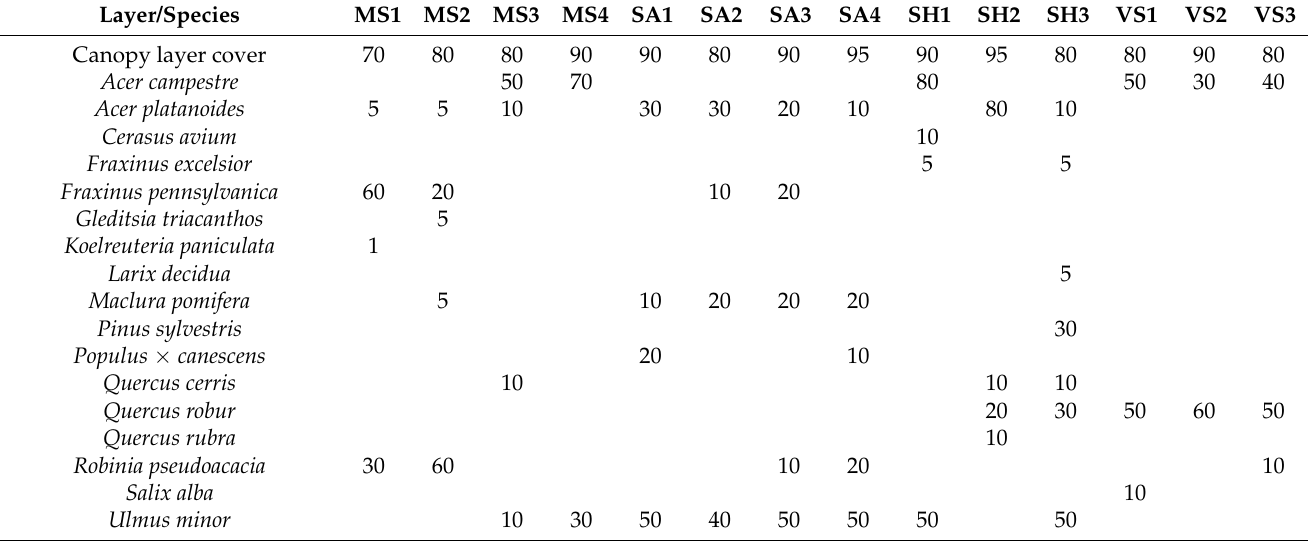
Table 3. Tree species composition and cover values (%) in the examined shelterbelts.